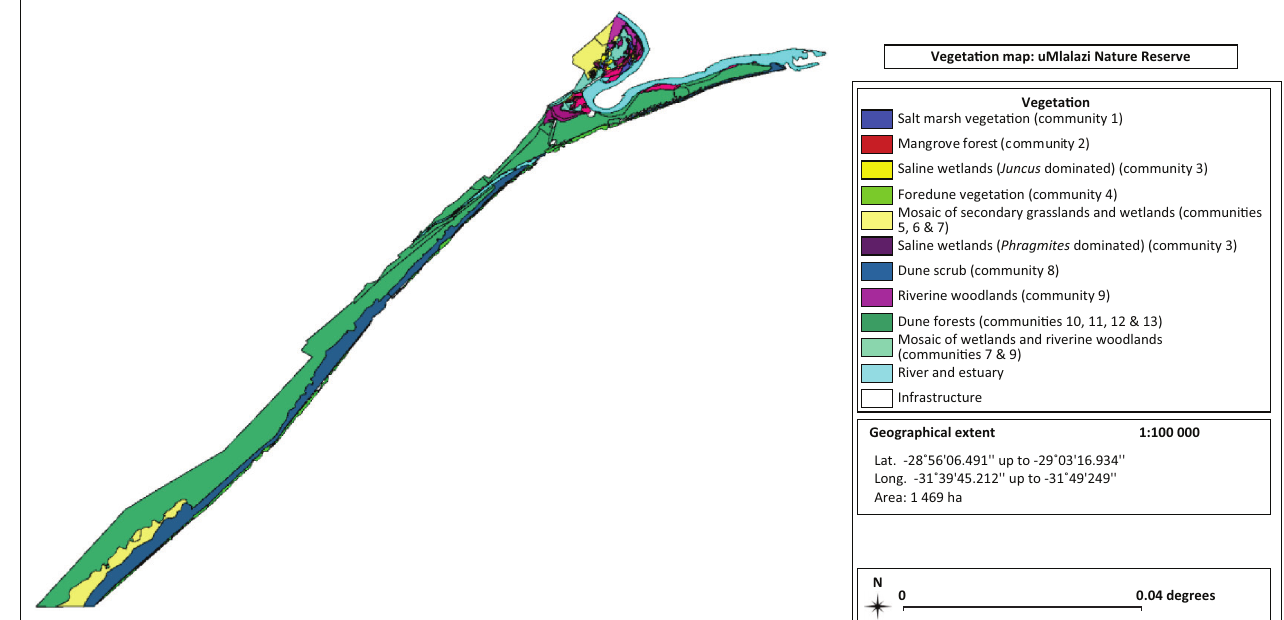
FIGURE 5: Vegetation map of the uMlalazi Nature